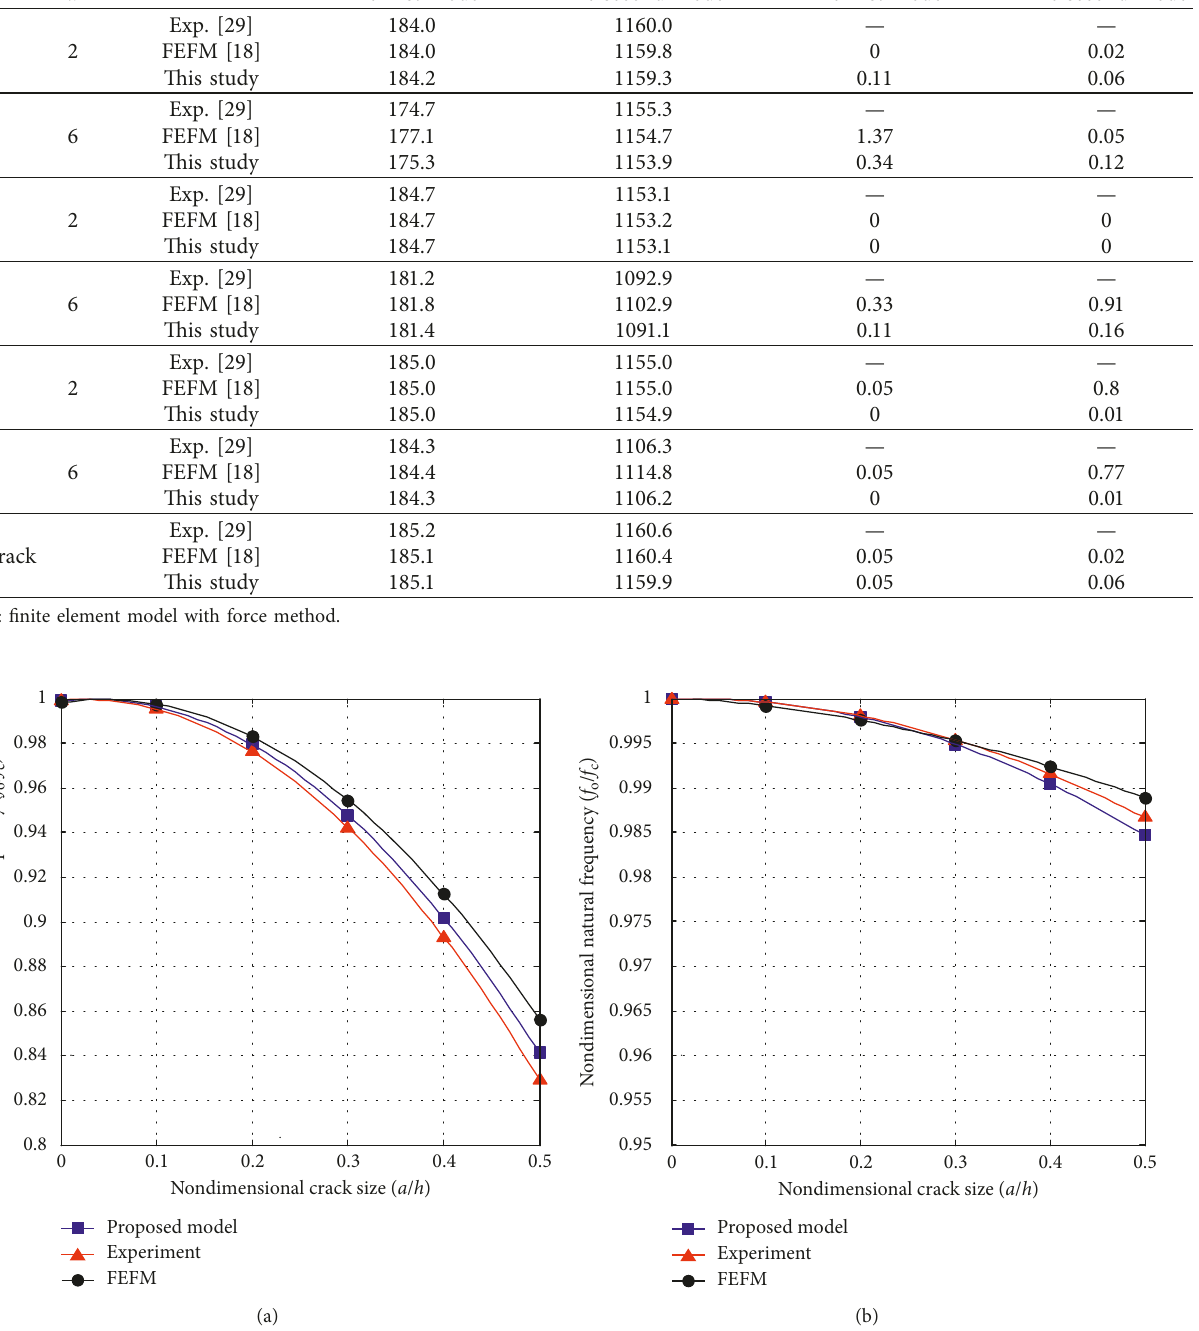
Figure 4: Comparison of the experimental natural frequencies with the FEFM and proposed model results for crack position X � 80mm: (a) the first mode; (b) the second